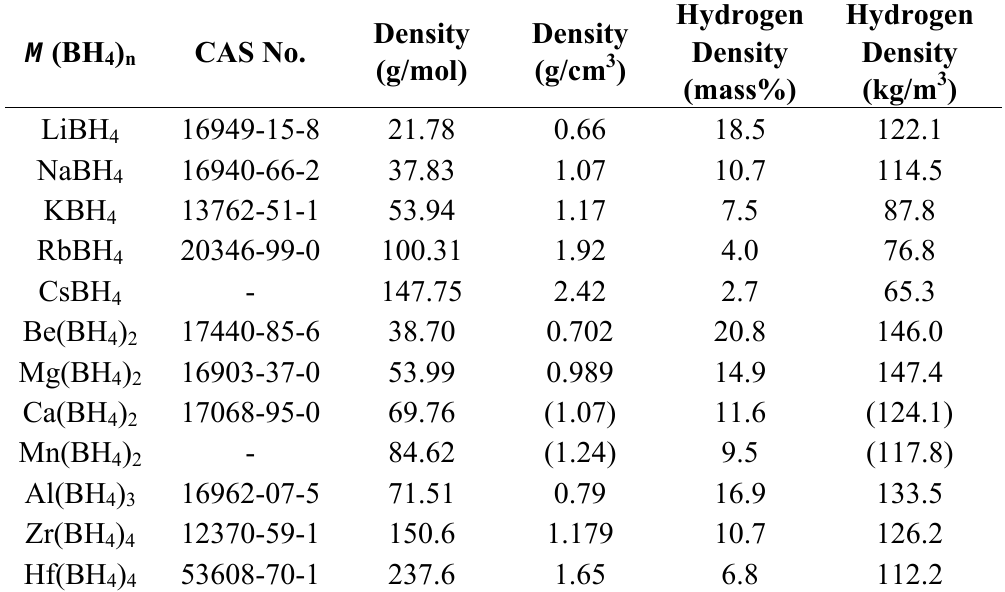
Table 1. Density of M (BH permission from reference